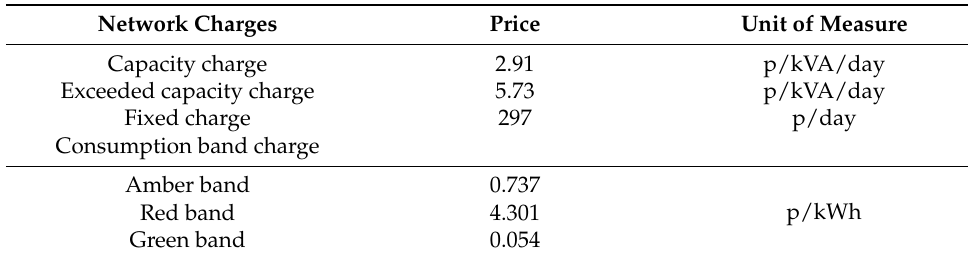
Table 2. Network charges for the WMD.